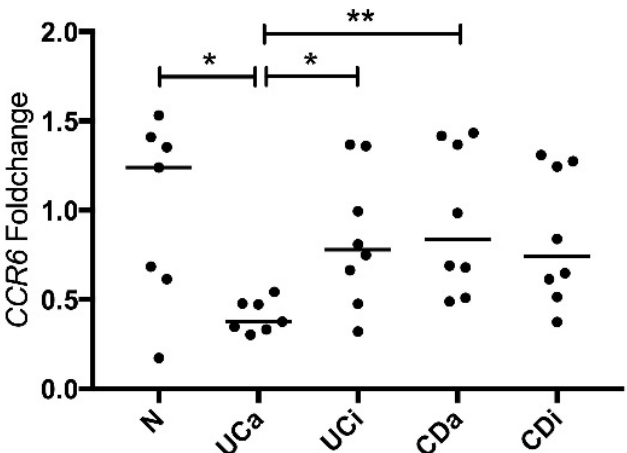
Figure 3. CCR6 mRNA PBMCs. CCR6 mRNA in PBMCs ( n = 38) from healthy controls (N), active ulcerative colitis (UCa) inactive ulcerative colitis (UCi), active Crohn’s disease (CDa) and inactive Crohn’s disease (CDi). Fold changes were determined relative to mean expression of the reference genes beta actin , TATA binding protein and eukaryote 18s rRNA and to the mean expression level in N. Individual fold change and median are plotted. Statistical comparison was performed using Kruskal-Wallis test followed by Mann-Whitney test with levels of significance denoted by * p < 0.05 and ** p < 0.01.